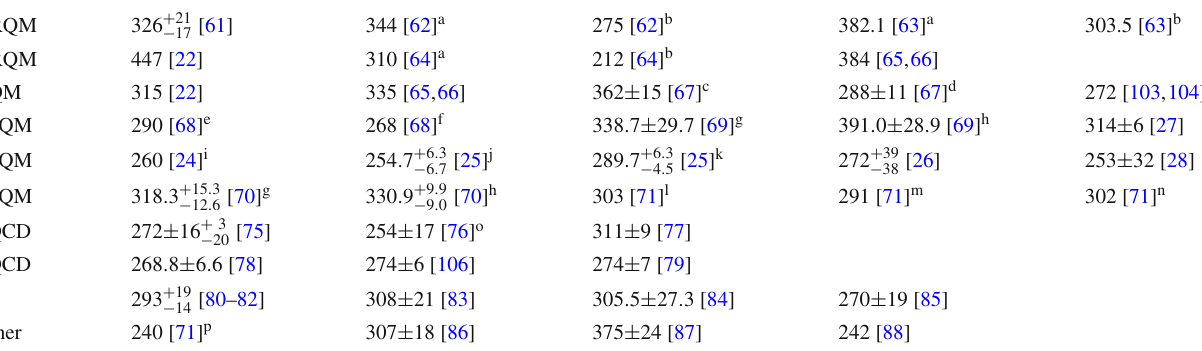
(in the unit of MeV), where the legends including the footnotes are the same as those in 3 s